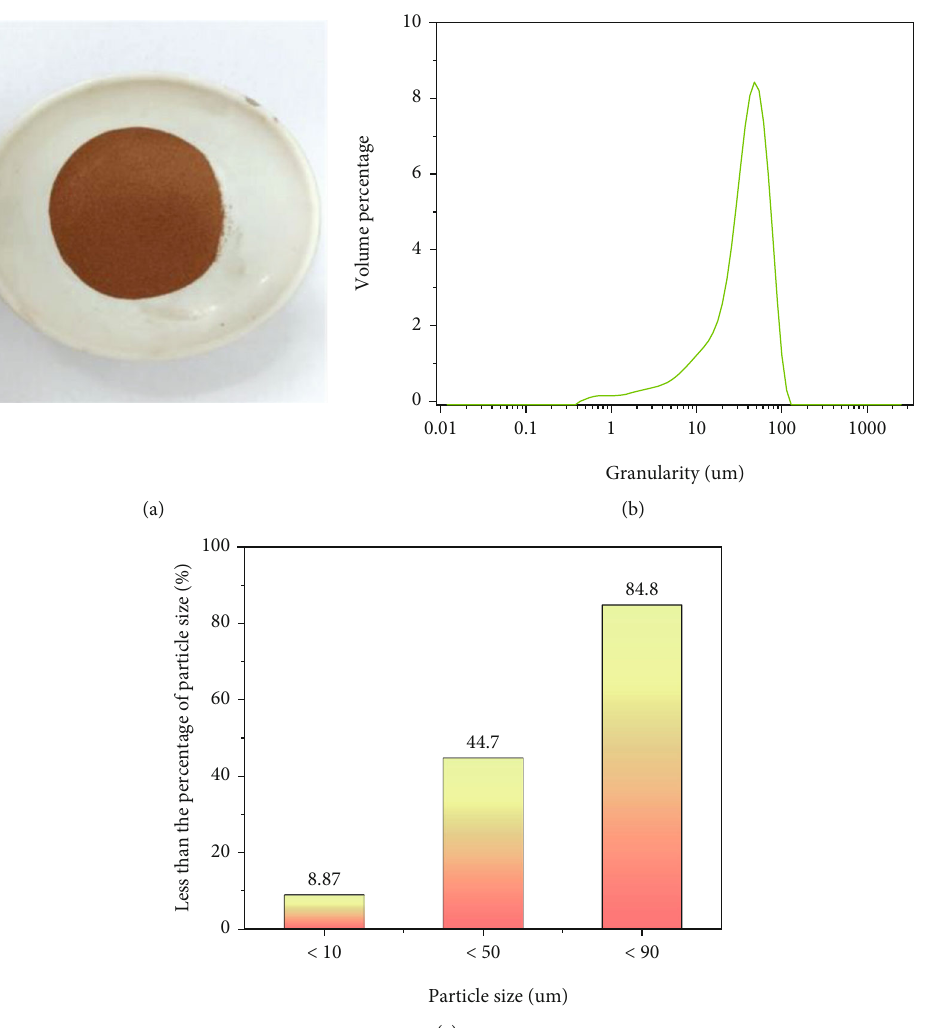
Figure 1: (a) Crushed red sandstone. (b) The proportion of di ff erent particle sizes of red sandstone. (c) The proportion of red sandstone smaller than a certain particle size. Table 1: GO elemental composition of graphene oxide (%). Elemental composition C O H S Content (%) 41.70 51.49 2.41